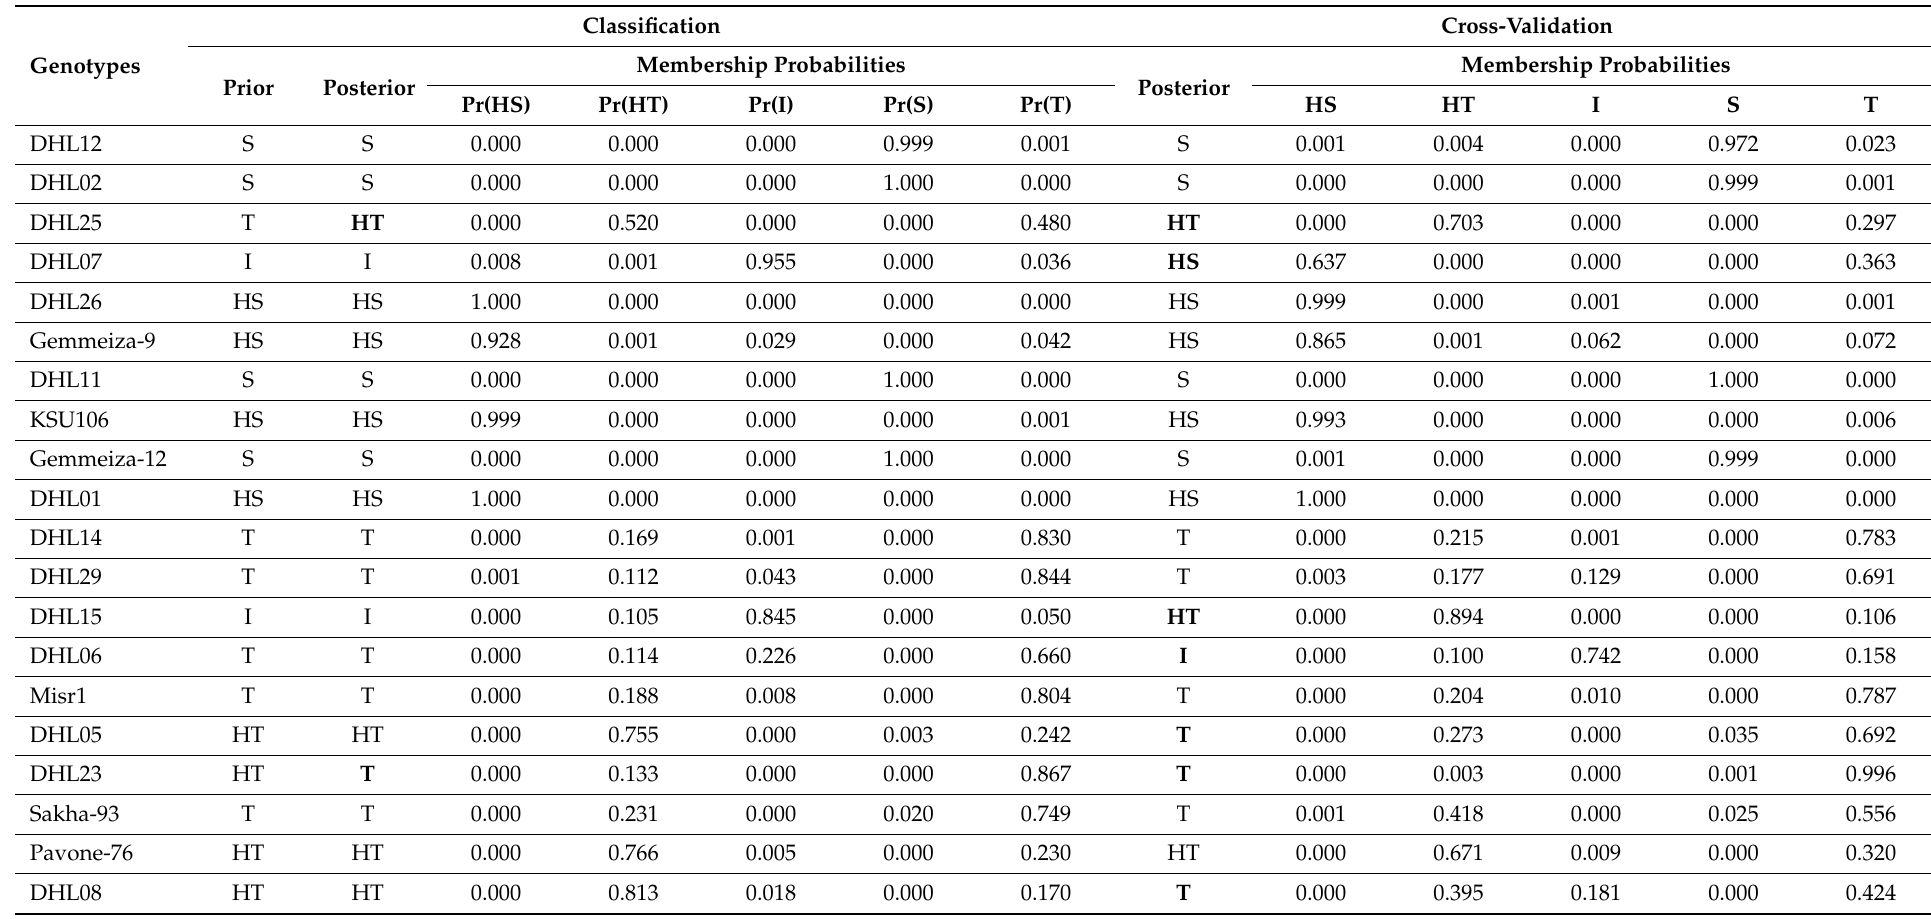
Bold letters indicate misclassified wheat